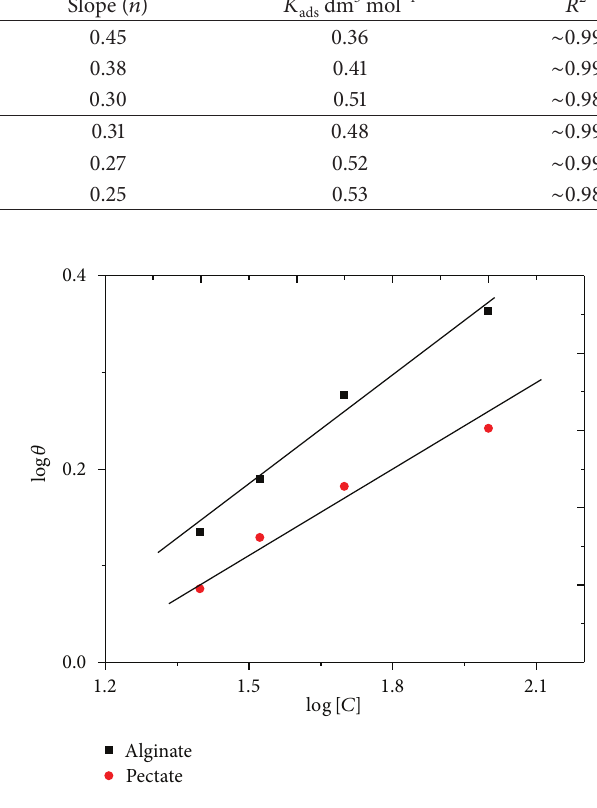
Figure 7: A plot of Freundlich isotherm for corrosion of Al in alkaline media at 35 ∘